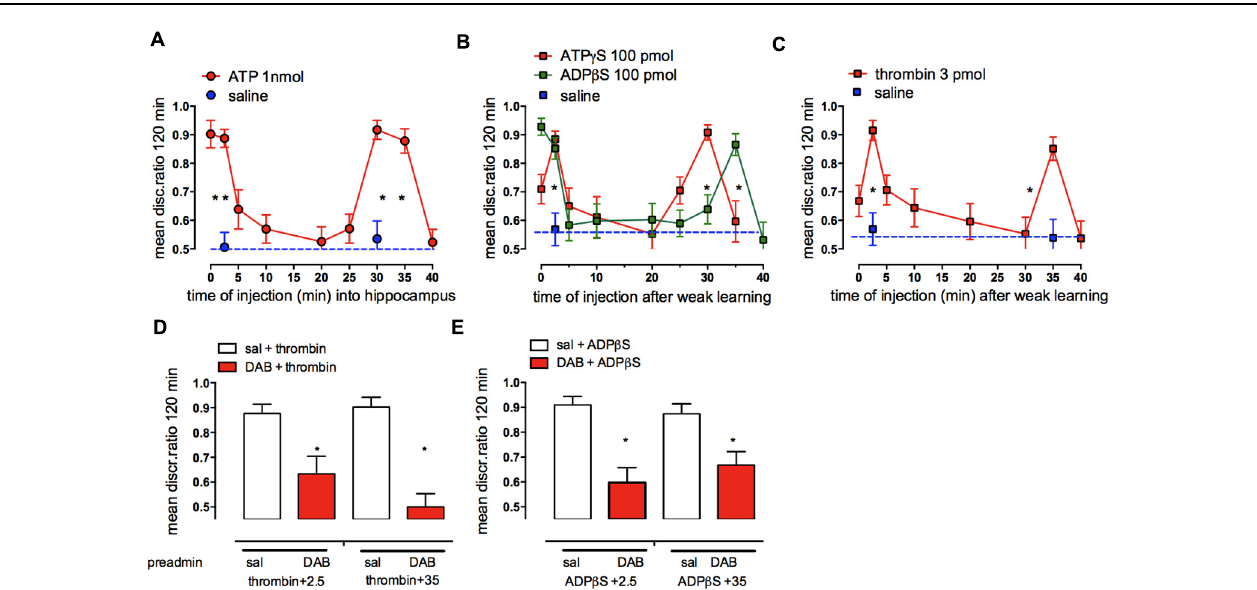
FIGURE 10 | Effect of hippocampal injection of ATP, ATP γ S, ADP β S, or thrombin (A–C) on consolidation of weakly reinforced training and the effect of DAB on the ability of thrombin, ADP β S to promote consolidation (D,E). Injections over two time periods after weakly reinforced training resulted in consolidation of memory 120 min after training. (A) ATP, (B) ADP β S and ATP γ S and (C) thrombin. (D,E) A sub-optimal dose of DAB (red columns) was injected subcutaneously 5 min before weakly reinforced training or 5 min before injection of thrombin or ADP β S into the hippocampus 2.5 or 35 min after weakly reinforced training, i.e., at times when they normally promote consolidation (open columns). * P < 0.05. (From Gibbs et al.,